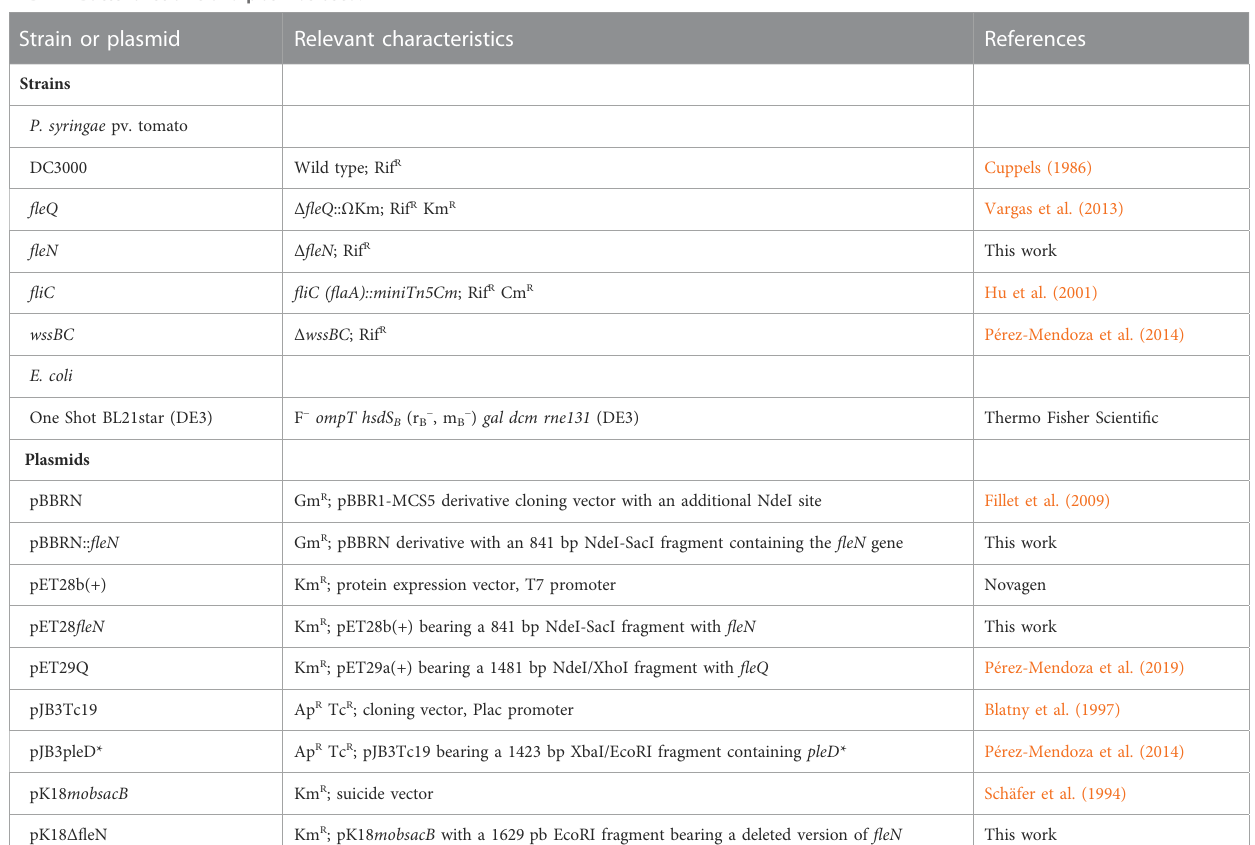
TABLE 1 Bacterial strains and plasmids